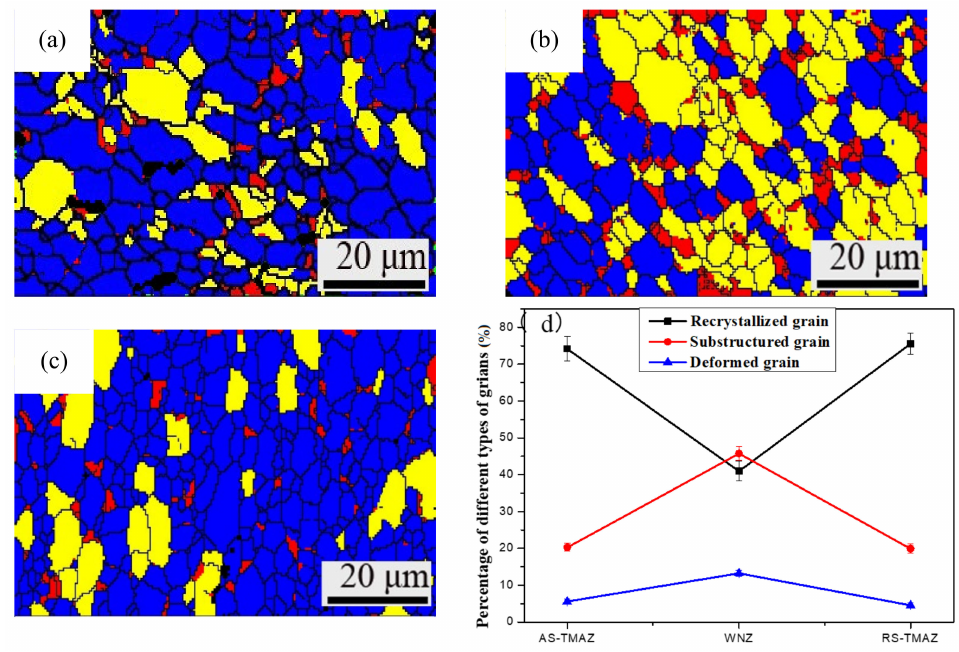
Figure 7. Grain recrystallization behavior maps: ( a ) AS-HAZ; ( b ) SZ; ( c ) RS-TMAZ; ( d ) Value of grain morphology of 7A52 aluminum alloy FSW